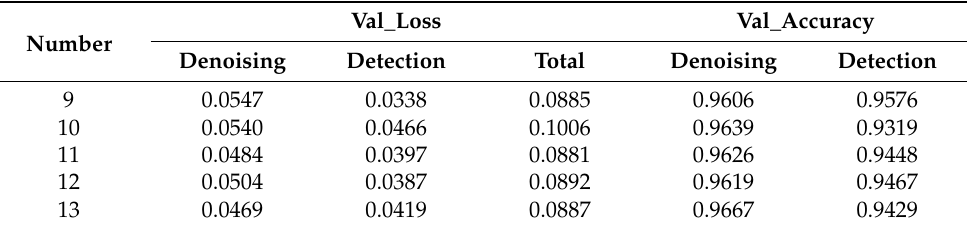
Table 2. Performance of PDTN with different downsampling times for the verification set.